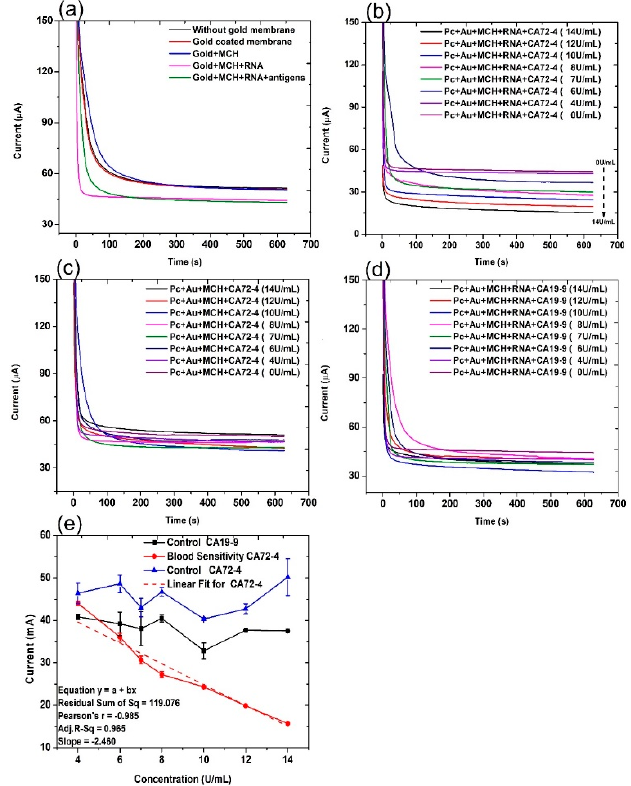
Figure 2. Current and time responses of the electrochemical sensor under different conditions. ( a ) Current and time responses of control samples and the sensor in the presence of 14 U/mL of CA 72-4 cancer antigen. ( b ) Current and time responses of electrochemical sensors in the presence of different concentrations of CA 72-4 cancer antigen. ( c ) Current and time responses of electrochemical sensor in the presence of different concentrations of CA 72-4 cancer antigen but without RNA aptamer. ( d ) Current and time responses of electrochemical sensors in the presence of different concentrations of CA 19-9 cancer antigen. ( e ) Calibration plots between the current of electrochemical sensor and the concentration of CA72-4 and CA19-9 in ( c – e ). Table 1. The peak assignments observed in the Raman spectra.